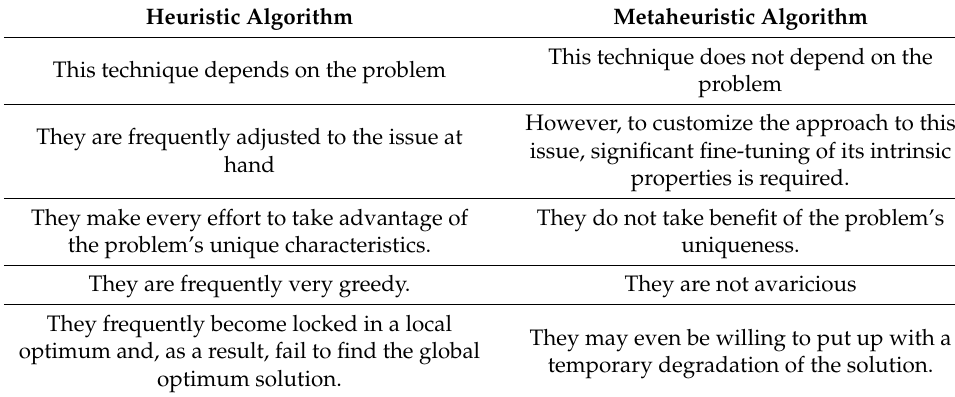
Table 5. Comparisons between Heuristic and Metaheuristic Algorithms [127]. Heuristic Algorithm Metaheuristic